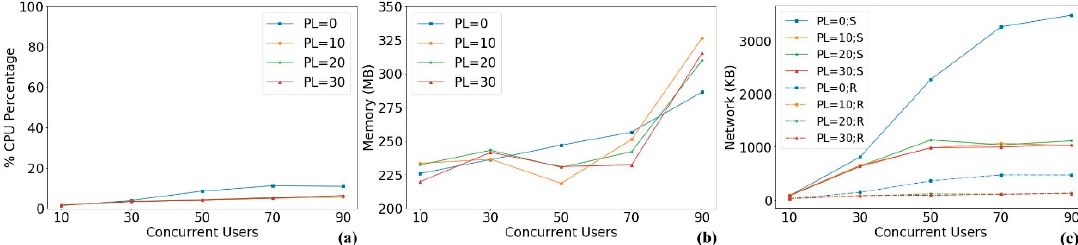
Figure 9. Server resource consumption with different numbers of concurrent users and packet lags: ( a ) CPU percentage; ( b ) memory; ( c ) network (PL stands for packet lag. S refers to sent traffic, while R refers to received traffic. Abbreviations in other figures have the same meanings).